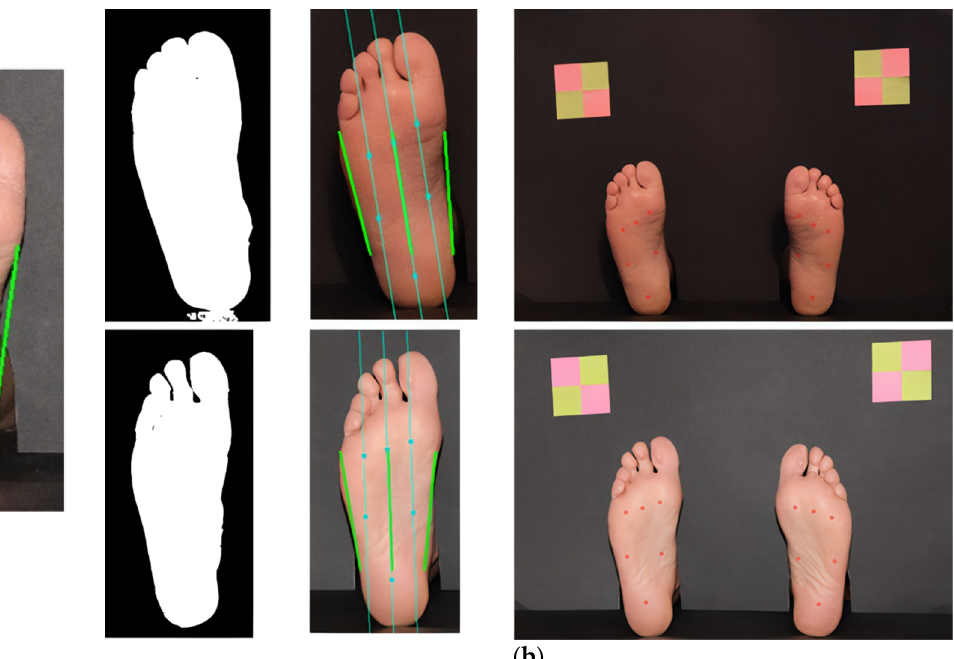
Figure 8. Processing details for the segmentation of the heel, central, and metatarsophalangeal sites. In ( a ), several proportion ratios that were used to draw reference lines can be observed. In ( b ), the application of the proposed algorithm is presented: the first column shows the binary image; the second column shows the left and right border guidelines, as well as the central reference directions for the testing sites; the third column shows the testing sites coordinates remapped on the original image.